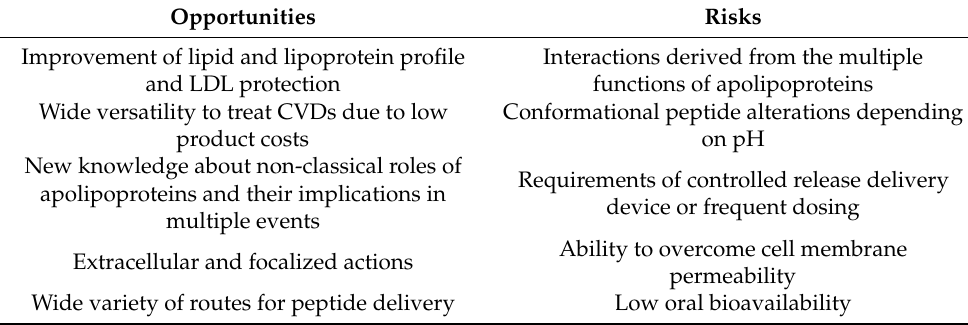
Table 4. Opportunities and risks associated with apolipoprotein-and LRP1-based peptides for therapy. Opportunities Risks Improvement of lipid and lipoprotein profile Interactions derived from the multiple and LDL protection functions of apolipoproteins Wide versatility to treat CVDs due to low Conformational peptide alterations depending product costs on pH New knowledge about non-classical roles of Requirements of controlled release delivery apolipoproteins and their implications in device or frequent dosing multiple events Ability to overcome cell membrane Extracellular and focalized actions permeability Wide variety of routes for peptide delivery Low oral